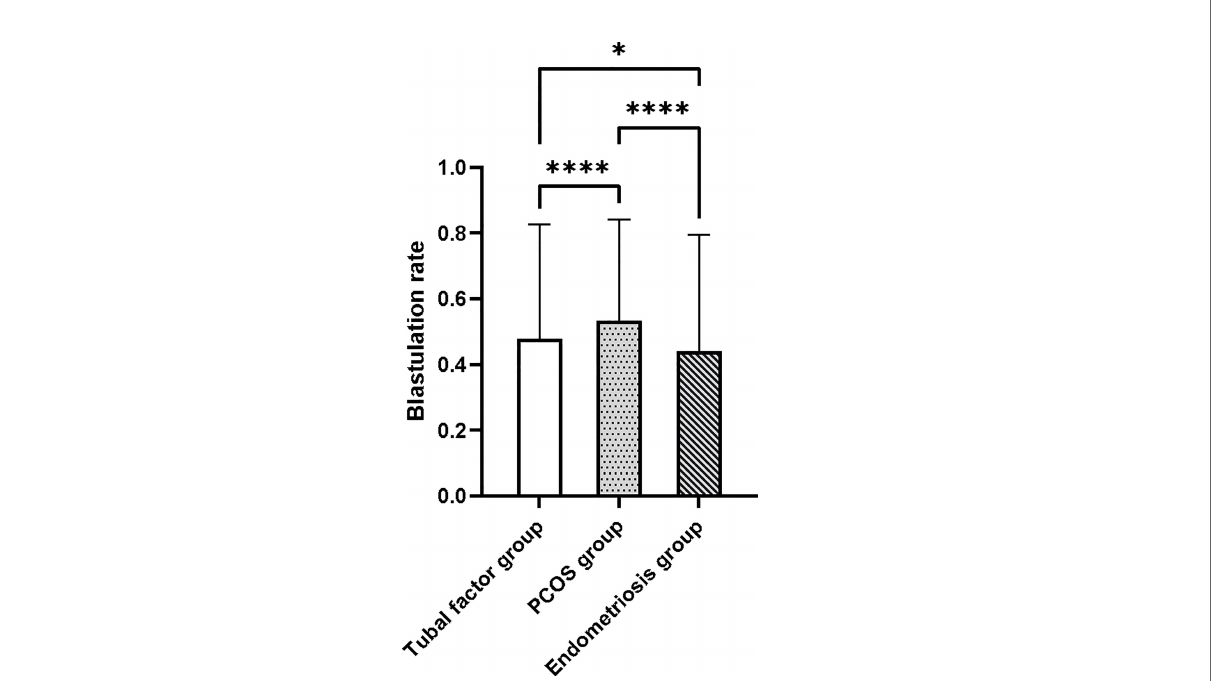
FIGURE 2 | The blastocyst formation rate was signi fi cantly different between the tubal factor group, the PCOS group, and endometriosis group by Dunnett ’ s t-test pair comparison. *p < 0.05, ****p < 0.001. PCOS, polycystic ovary